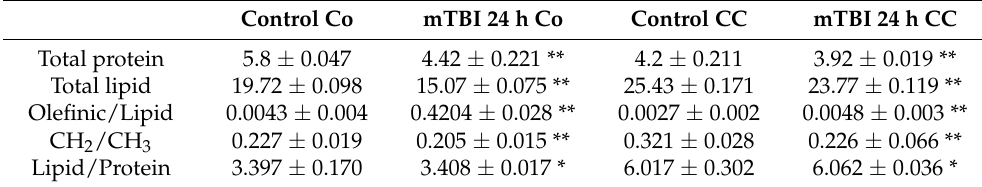
Table 2. The changes in content and area ratios of some biomolecules in control and mTBI